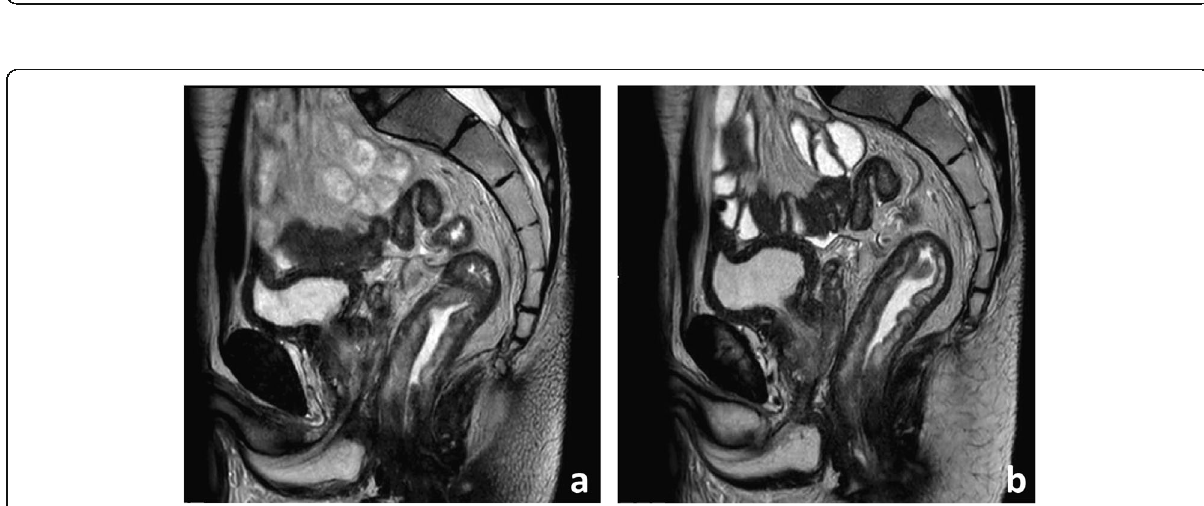
Fig. 4 Sagittal T2-weighted images before ( a ) and 5 min after ( b ) IV administration of a spasmolytic agent (butylscopolamine 20 mg). Notice how the walls of the rectum and small bowel are much better defined due to limited